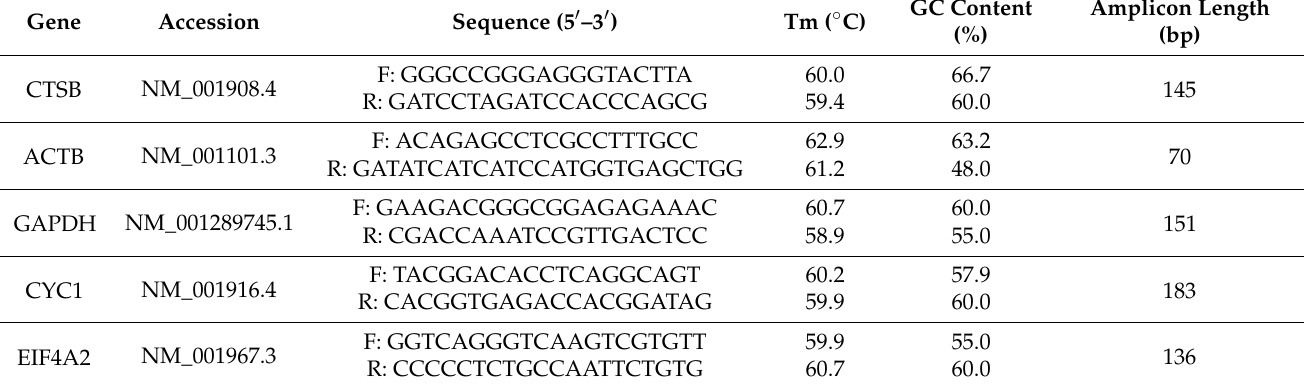
Table 2. Quantitative Real-Time PCR primers. Sequences of forward (F) and reverse (R) primers used to amplify cDNA fragments in qPCR analysis. The corresponding gene is shown along with primer GC content, and expected amplicon length in base pairs. Primers were designed using PrimerBlast (NCBI) against the listed accession number for each gene and to span exon–exon junctions. CTSB: Homo sapiens cathepsin B; ACTB: Homo sapiens actin beta; GAPDH: Homo sapiens glyceraldehyde-3-phosphate dehydrogenase; CYC1: Homo sapiens cytochrome c1; EIF4A2: Homo sapiens eukaryotic translation initiation factor